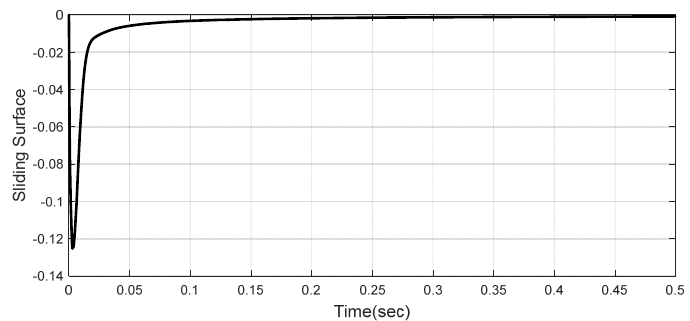
Figure 22. Sliding surface in the presence of measurement noise.